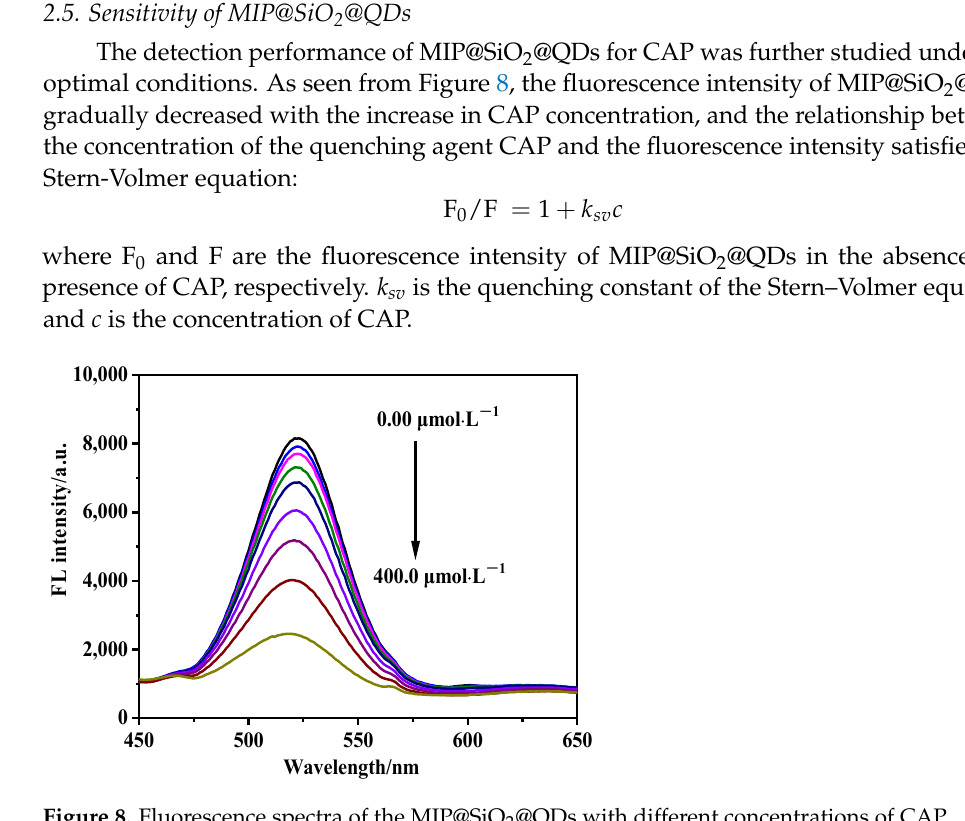
Figure 7. Effect of pH on the fluorescence of MIP@SiO 2 @QDs (taking the pH of 8.0 as the suitable